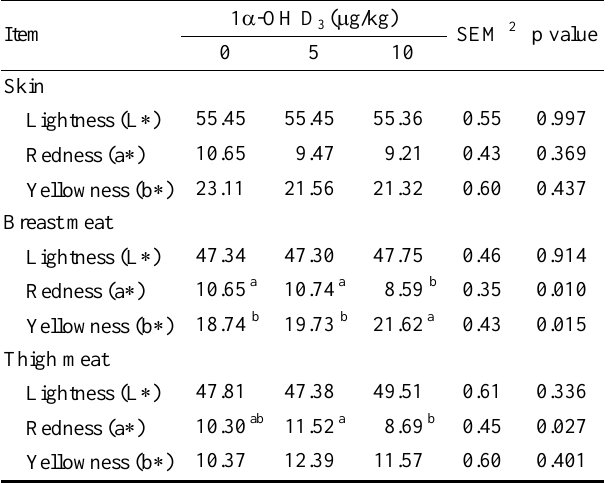
Table 4. Effect of 1  -OH D 3 on small intestine length and weight of 21- to 42-d-old broilers